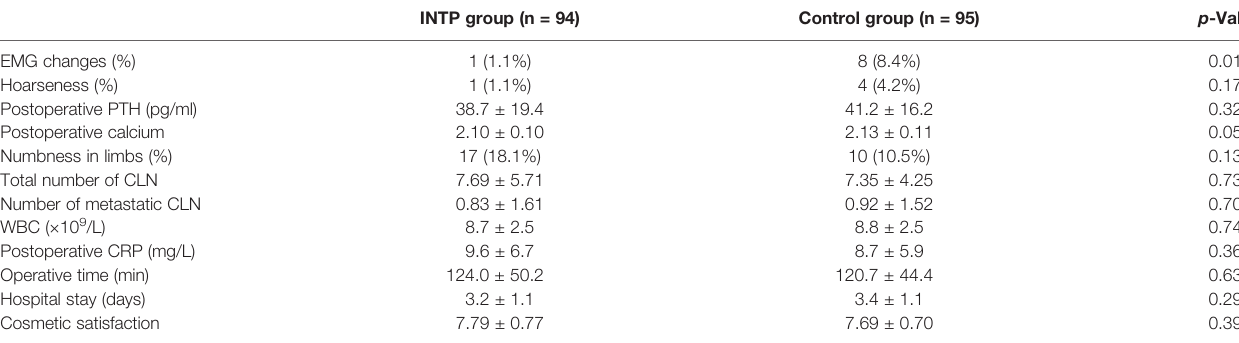
TABLE 5 | Effective assessment of INTP in trans breast endoscopic